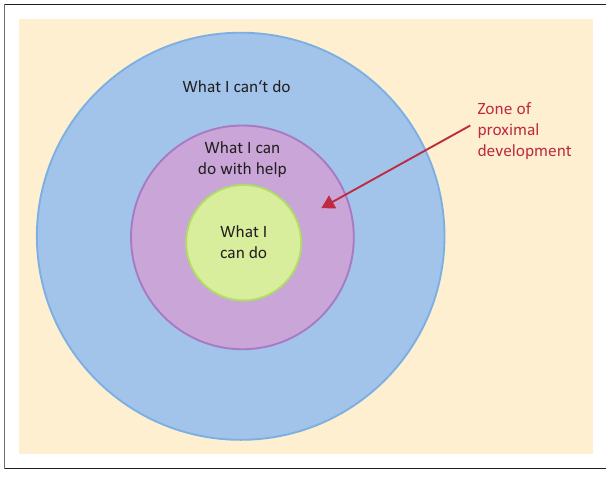
FIGURE 1: Diagram showing what teachers should do to be able to assist learners within the Zone of Proximal